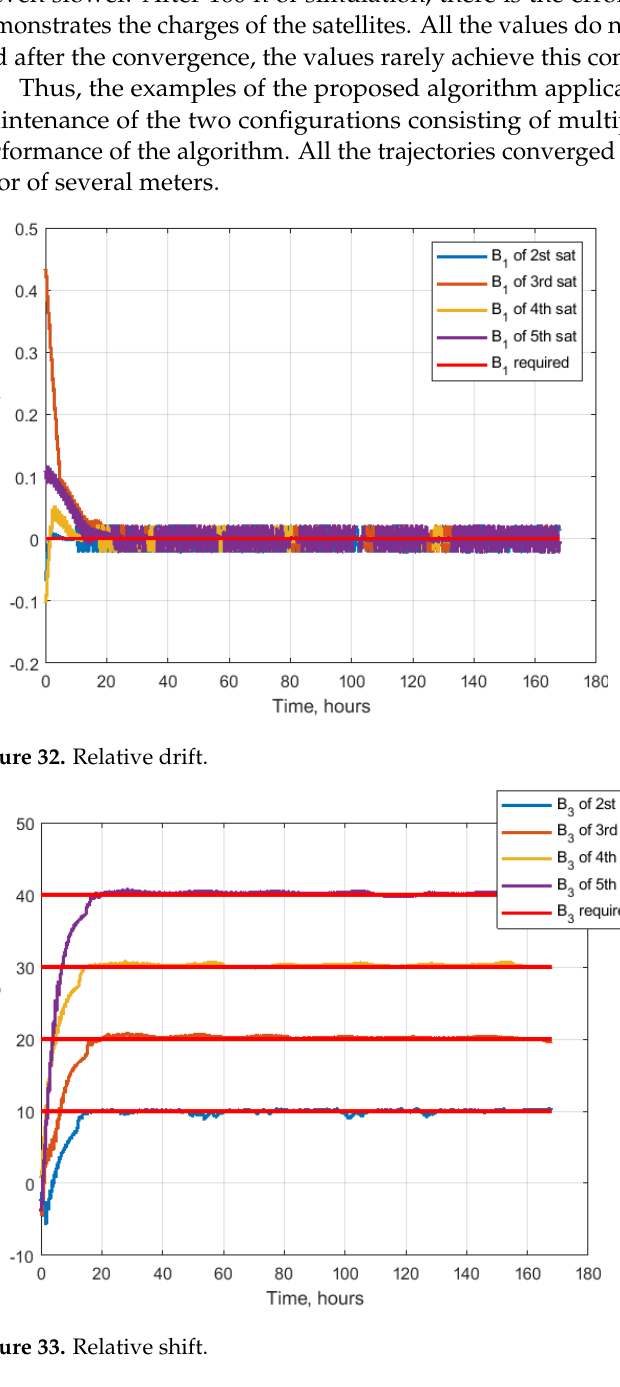
Figure 31. Relative trajectories during the last 2 h of simulation.